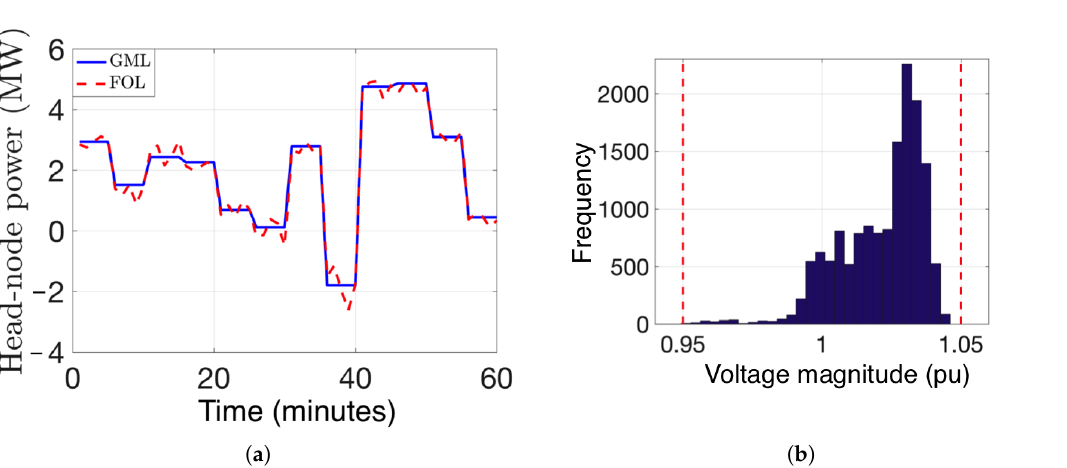
Figure 8. Left: ( a ) Tracking of the reference grid market layer (GML) head-node power by the feeder operational layer (FOL) through the control of VBs showing acceptable tracking performance for the period 13:00–14:00 Right: ( b ) Histogram of the voltages obtained from the stochastic AC OPF. Clearly, the voltages are within the ANSI limits given by the red dashed vertical